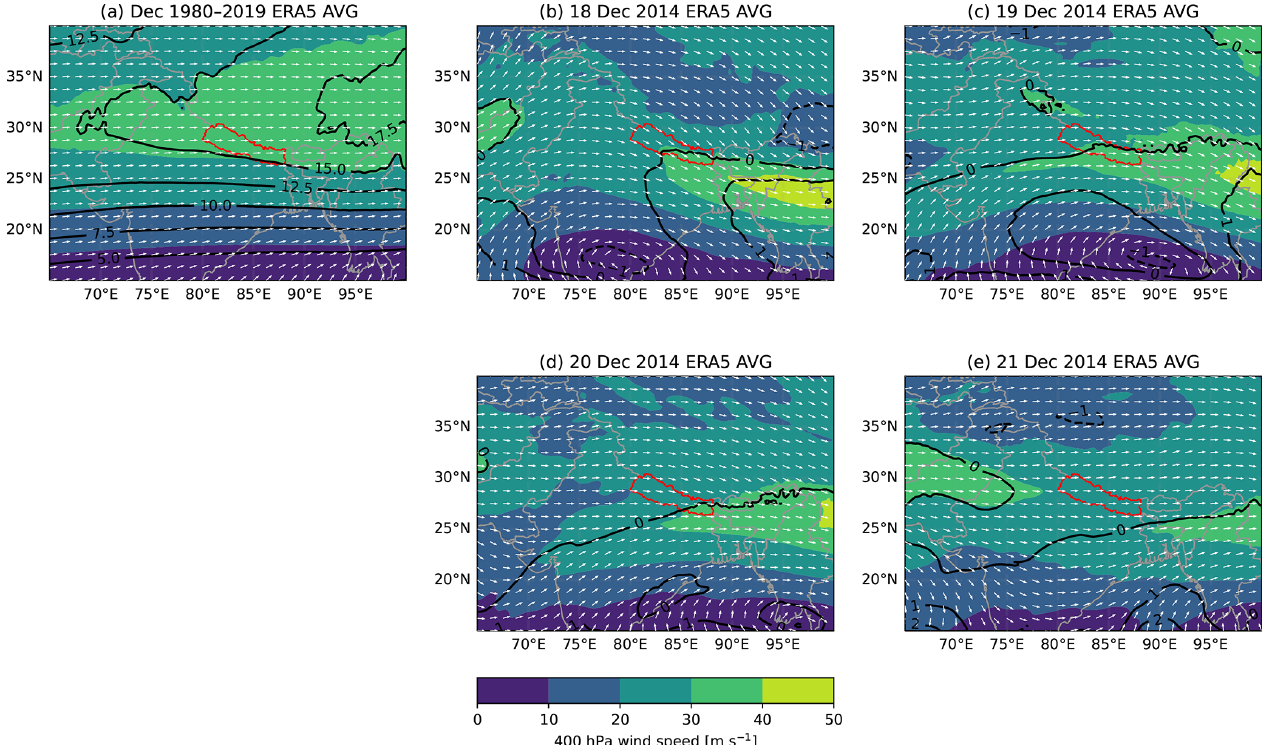
Figure 1. (a) The 400hPa wind speed (shading) and direction (white vectors) averaged over the month of December for the period from 1980 to 2019 in the ERA5 reanalysis. The standard deviation of the 40-year monthly means is shown by the black contours (ms − 1 ). (b–e) Daily averaged wind speed and direction at 400hPa in the ERA5 reanalysis for the period from 18 to 21 December 2014. The standard score of the daily average wind speed compared to the 40-year monthly means is shown by the black contours with a contour interval of 1SD. Coastlines and country borders are shown in grey, and the borders of Nepal are shown in